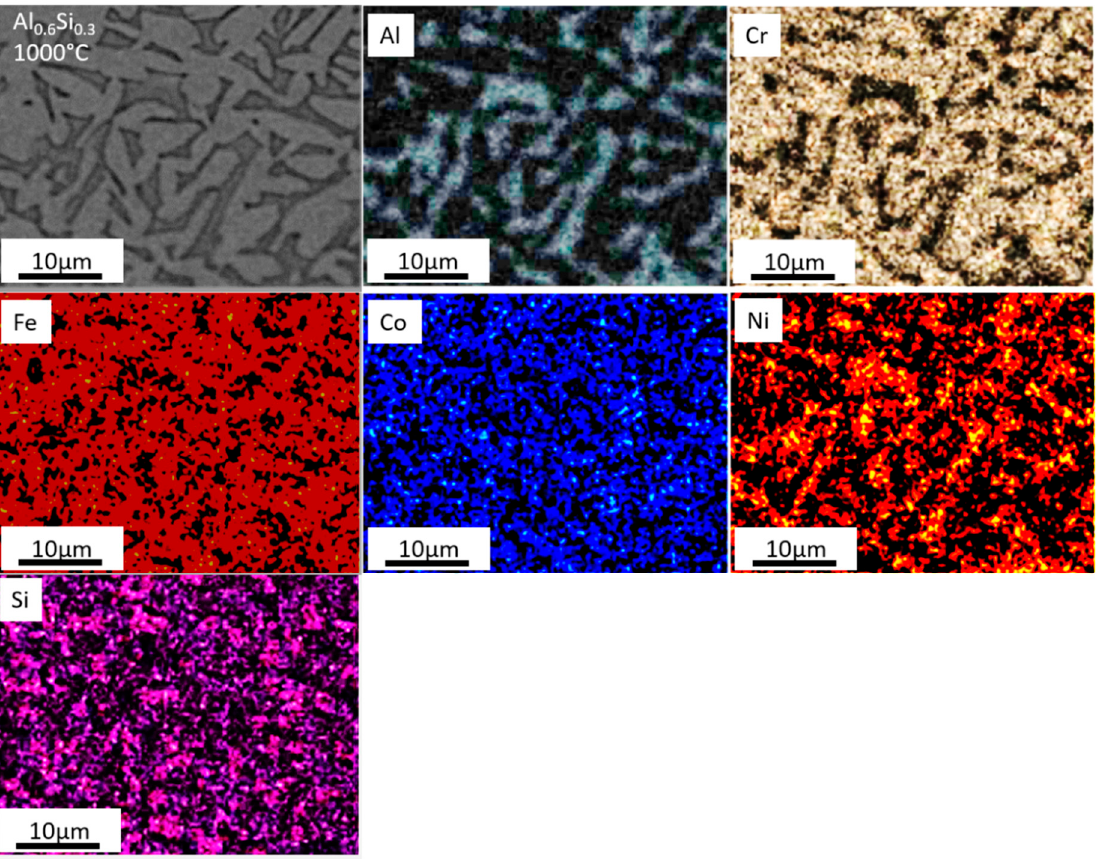
Figure 8. BSE SEM-micrographs and EDS map scan of Al 0.6 Si 0.3 after heat treatment at T = 1000 °C.